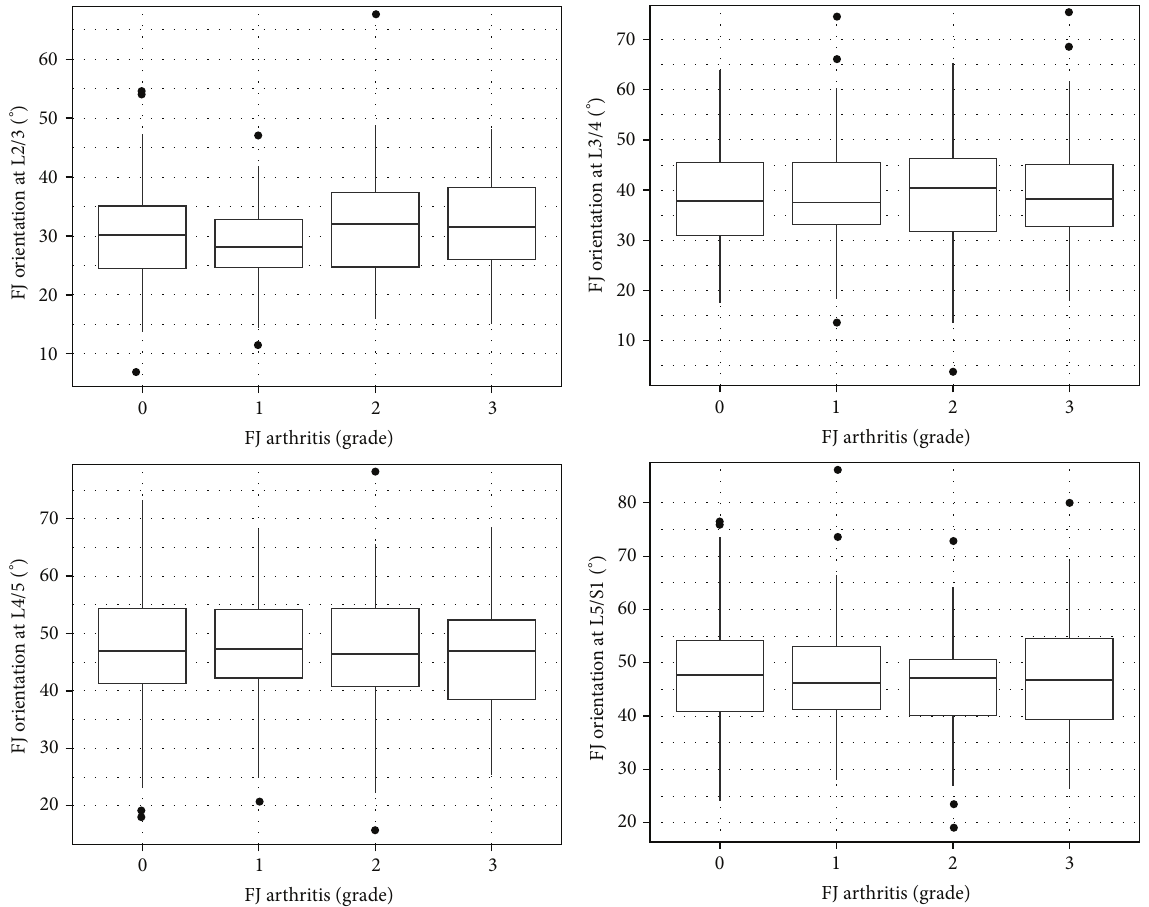
Figure 5: Cephalocaudal change in FJ orientation. There was a steady progress from a sagittal toward a more coronal FJ orientation at the lumbar spine in a cephalocaudal fashion, namely, 30 ∘ at L2/3 and 47 ∘ at